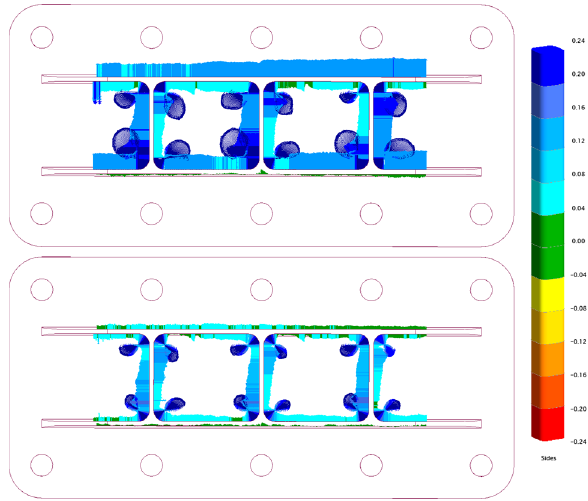
Figure 29. Comparison of measured stiffener profile vs. nominal CAD. (top) without feedback; (bottom) with feedback. Errors are indicated in mm.